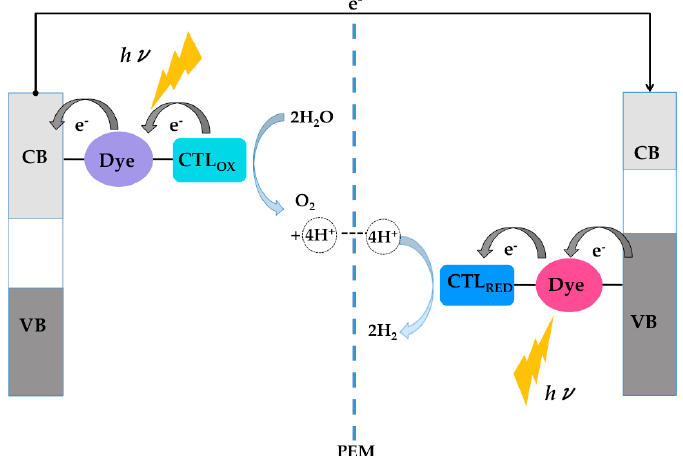
Figure 2. Scheme of a DSPEC for H 2 production composed by a photoanode and a phtocathode decorated with dye-CTL assemblies. PEM is a proton exchange membrane.